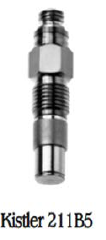
Figure 3. Photo of Pressure Sensor.